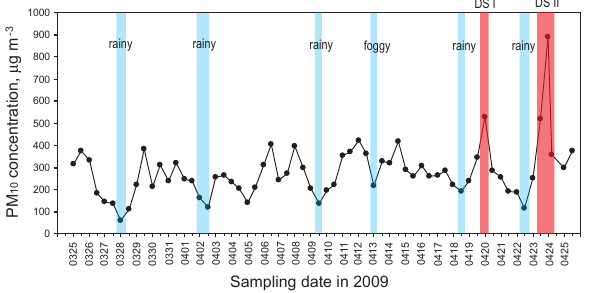
Figure 4. Temporal variation of PM10 in Xi’an during the spring of 2009 (DS I and DS II in red colour represent the two dust storm events occuring on April 20th and 24th, respectively)